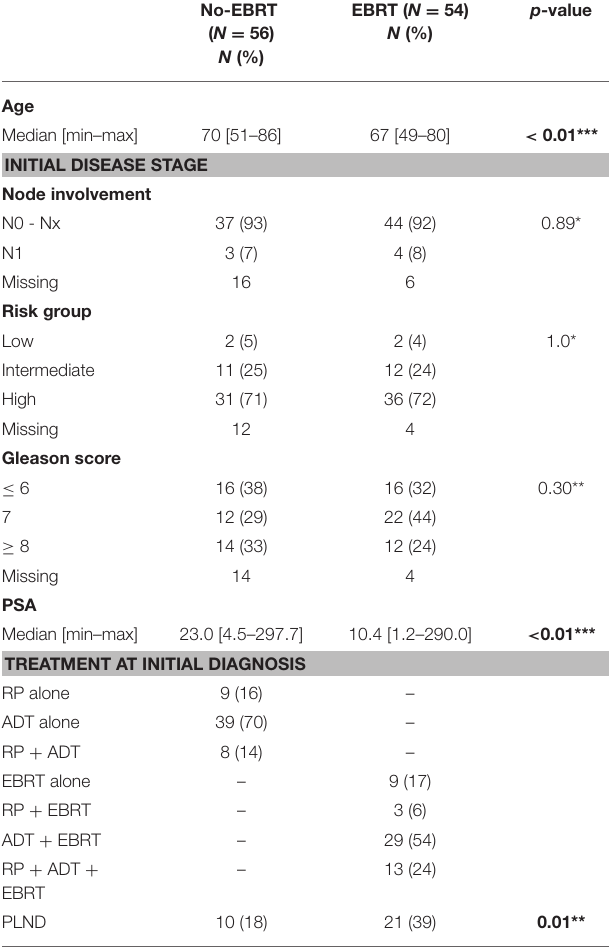
TABLE 1 | Baseline characteristics of the study